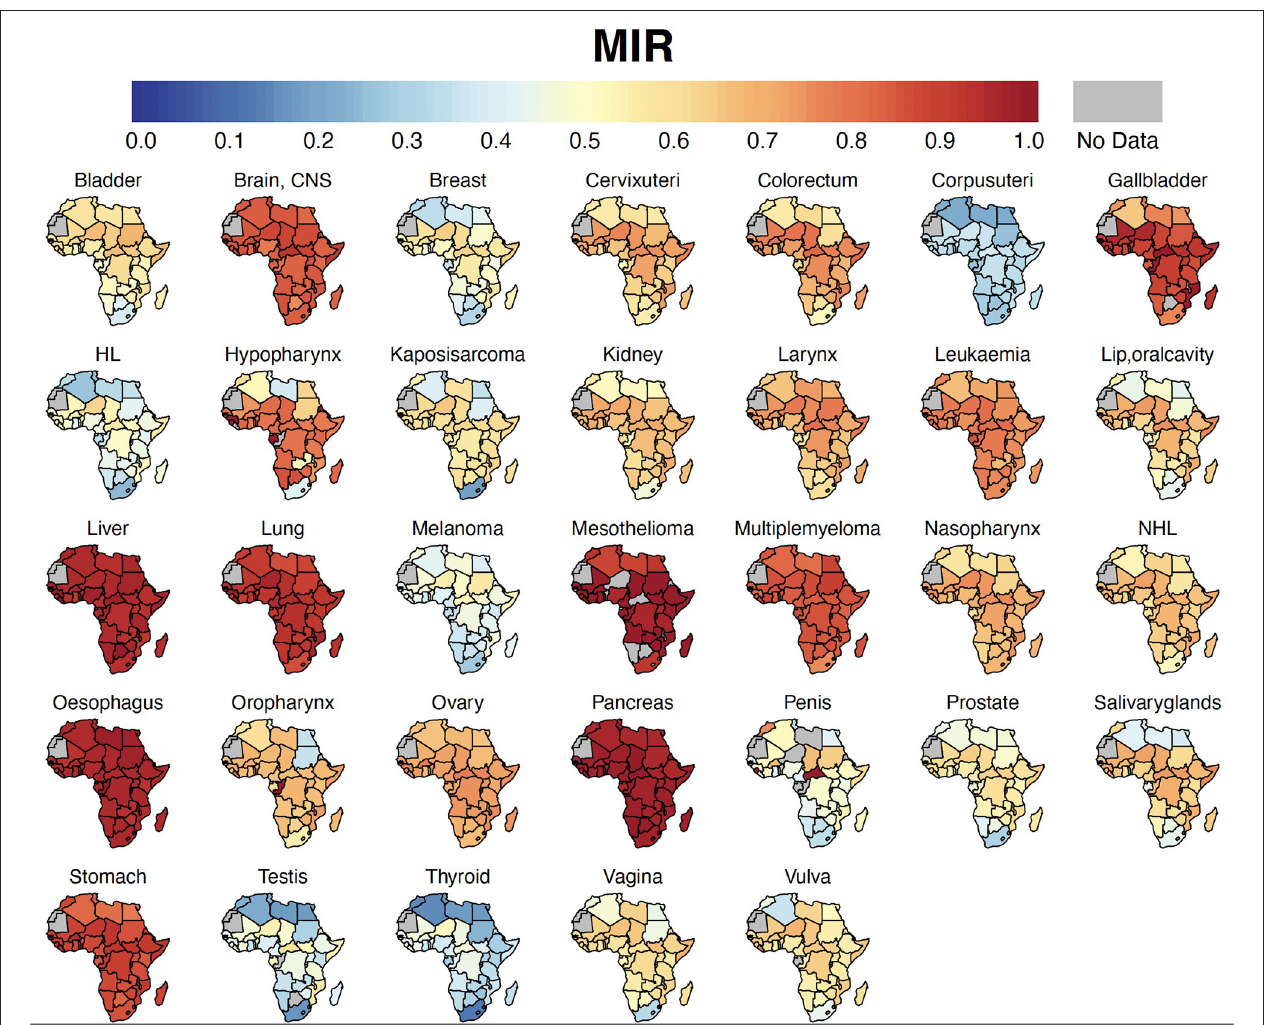
FIGURE 3 | Country-specific MIR. Cancer MIR (proxy for 5-year survival rate) for each country in Africa. MIR, Mortality-to-incidence ratio; HL, Hodgkin Lymphoma; NHL, Non-Hodgkin Lymphoma; CNS, Central Nervous System.